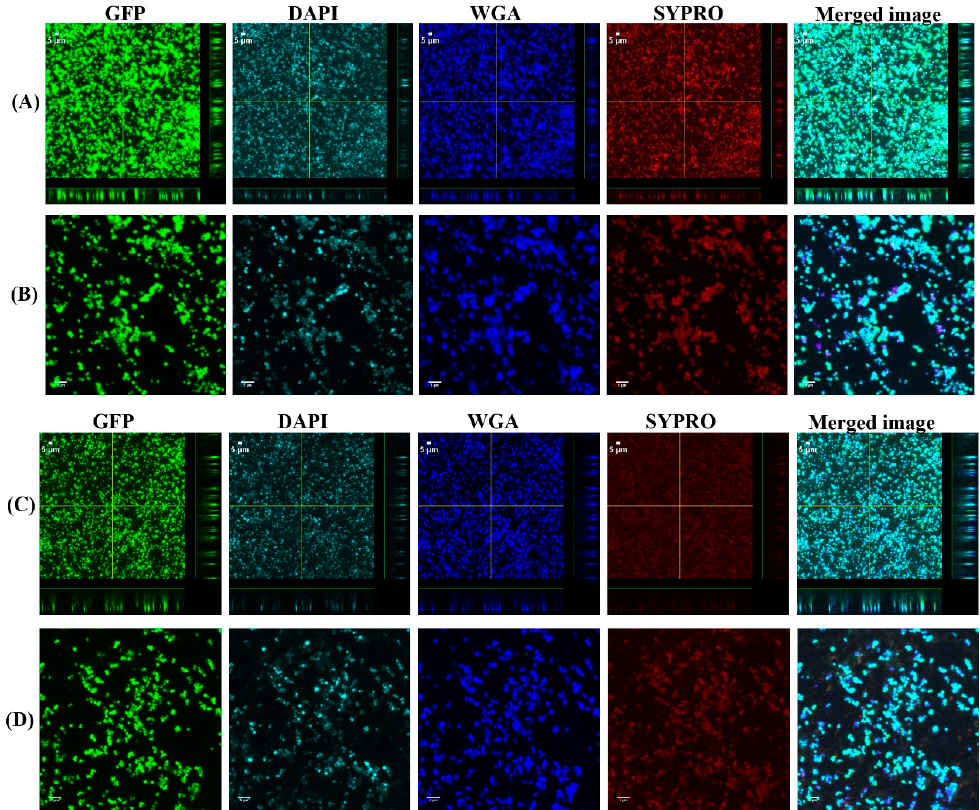
Figure 2. Confocal images of aggregated ( A , B ) and single cells ( C , D ) biofilms for 10 8 CFU/mL. Panel B and D are zoomed images. Biofilms stained with DAPI for eDNA, WGA stain for PNAG or SF-derived HA, and SYPRO for staining proteins contained in the biofilm matrix. Merged images denote the combination of GFP, DAPI, WGA, and SYPRO images.